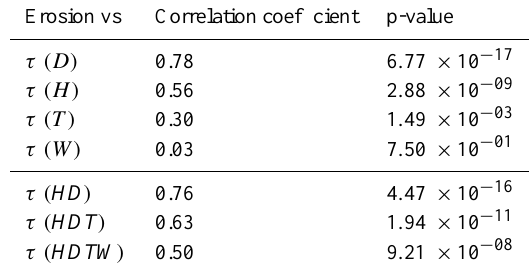
Table 1. Kendall’s tau correlation coefficients between the simu- lated erosion return periods and the various multivariate storm re- turn periods. The statistical significance of the correlations are indi- cated by their corresponding p-values.